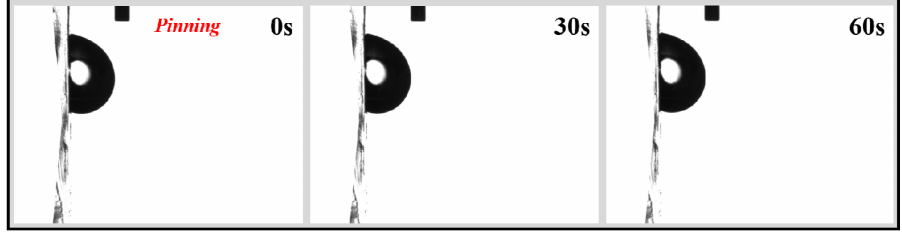
Figure 6. The pinning state of the water droplet on the pure sample